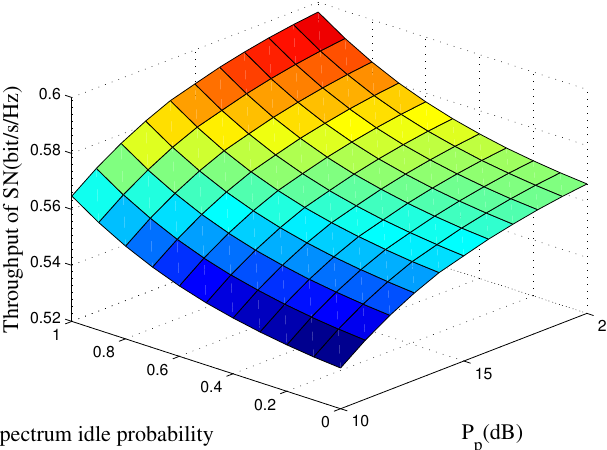
Figure 6. SN’s average throughput of the proposed strategy as a function of the PT’s transmit power P b and spectrum sensing time τ . The idle probability is set to P ( H 0 ) = 0.8, and the target secrecy outage probability is set to P th =